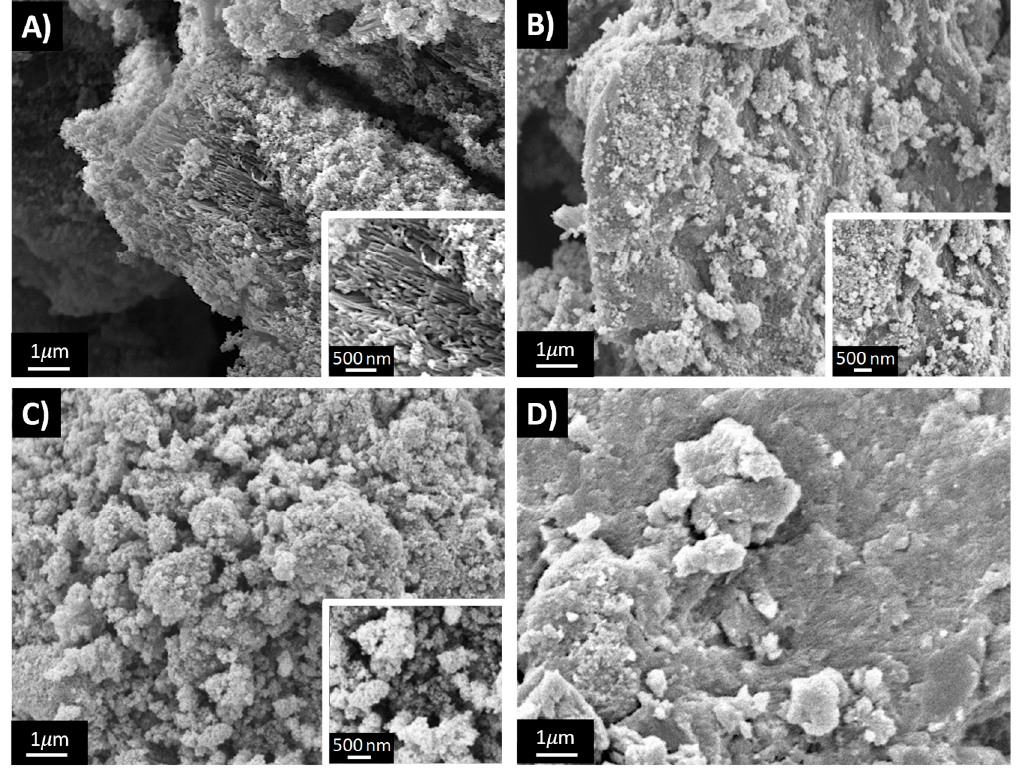
Figure 4. SEM images of: A ) 1 × 1, B ) 3 × 3, C ) 3 × 1, D ) 1 × 3.